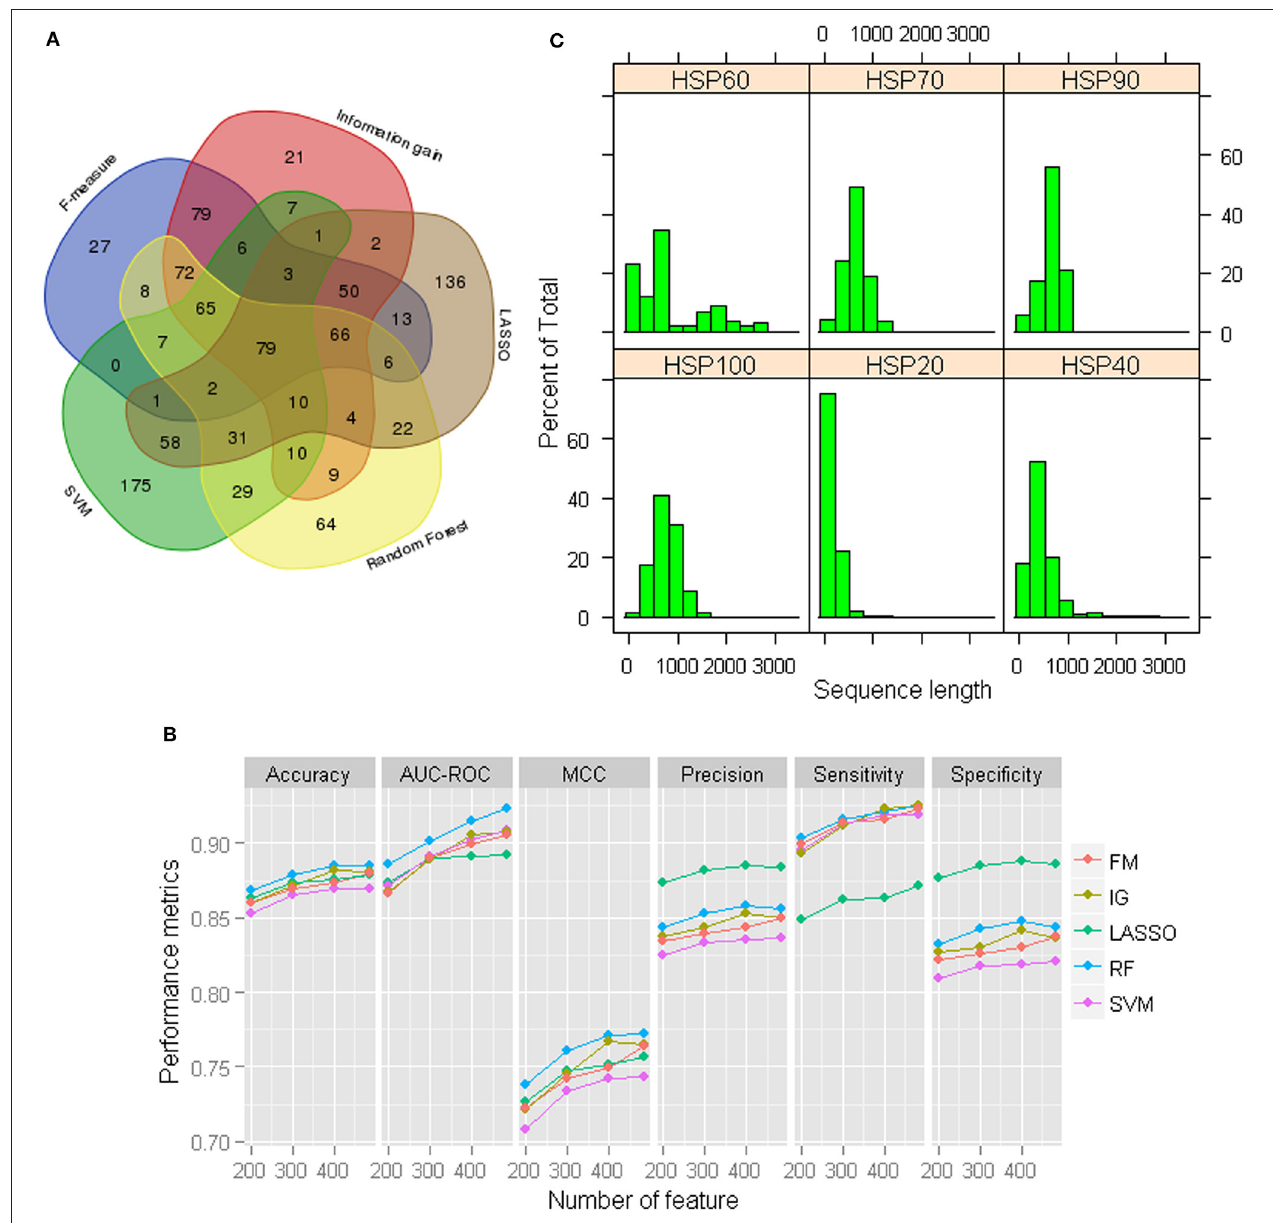
FIGURE 2 | (A) Venn diagram of the selected 484 features under each feature selection technique. It can be seen that a large number of features selected under LASSO and SVM are not common to the features selected under other techniques. On the other hand, most of the features selected through F-measure and Information gain are among those selected under other three techniques. (B) Performance metrics for SVM with RBF kernel with 484 selected GPC-0123 features under each feature selection technique. It can be observed that values of performance metrics are higher for RF-based selected 484 GPC-0123 features. (C) Distribution of length of sequences for each family of